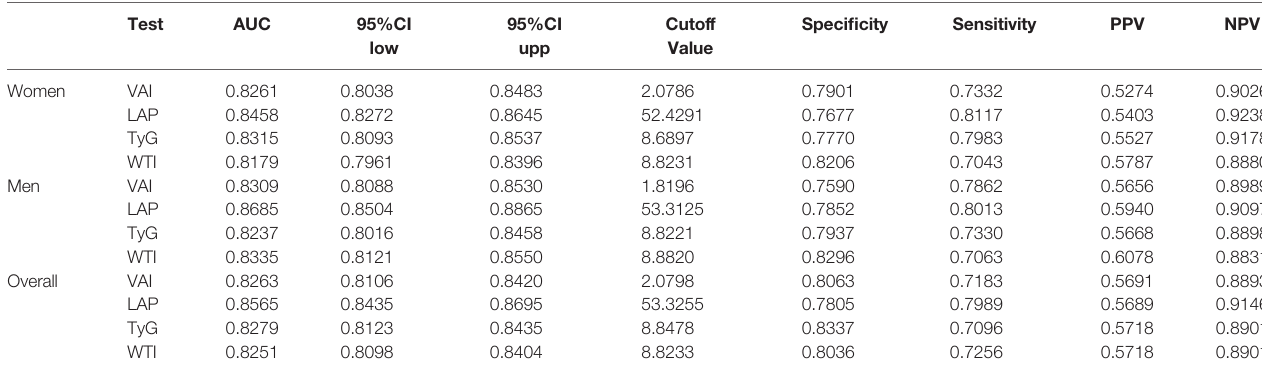
TABLE 2 | The anthropometric indexes for predicting